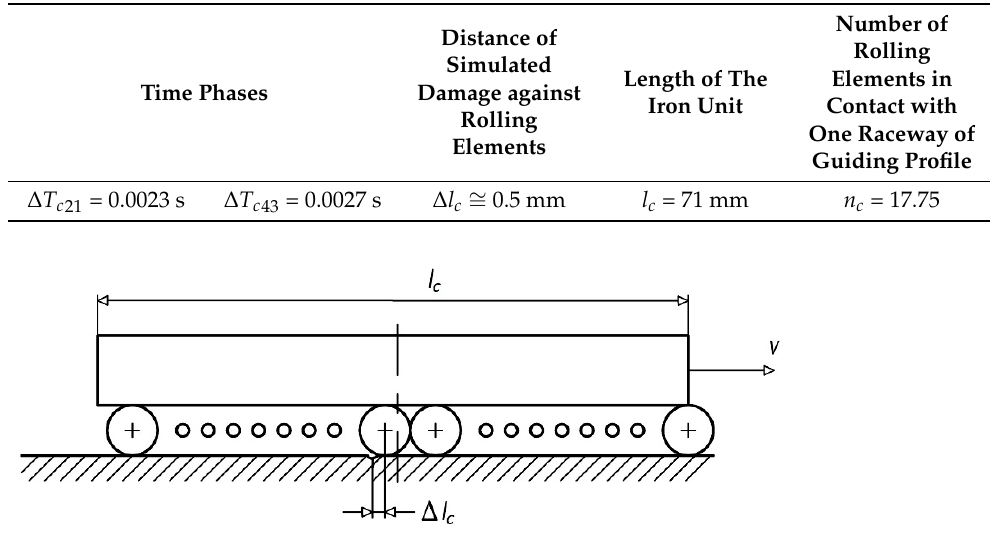
Table 7. Results of Equations (17)–(20).